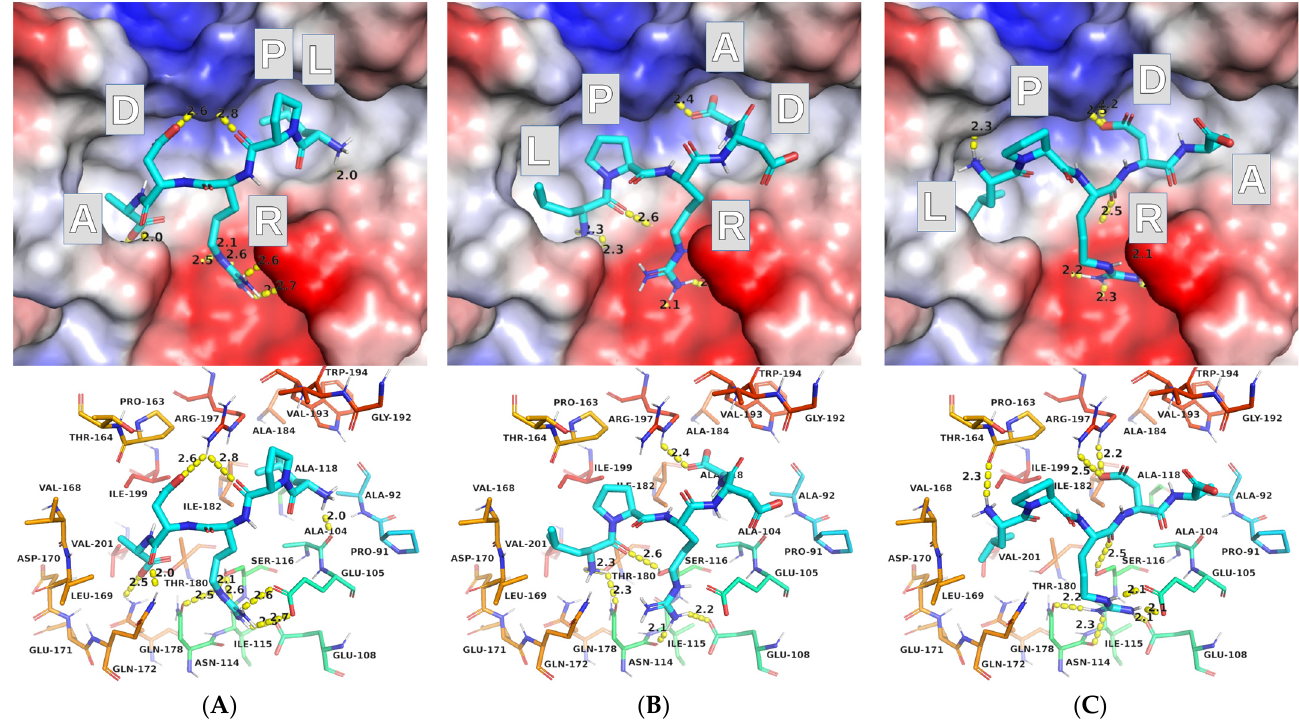
Figure 1. AutoDock Vina binding modes for LPRDA–SrtA complex: ( A ) mode #1—“reverse order”—“ADRPL” (from left to ring in the view), ( B ) mode #7 “direct order”—“LPRDA”, ( C ) mode #11 “direct order”—“LPRDA”. All images were made using the same view in PyMol.